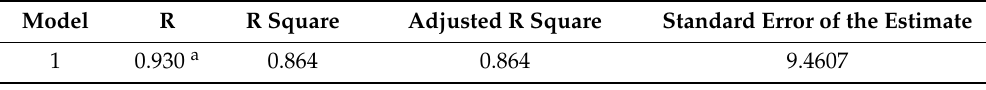
Table 9. Model summary of the TCC% based on the NDVI.